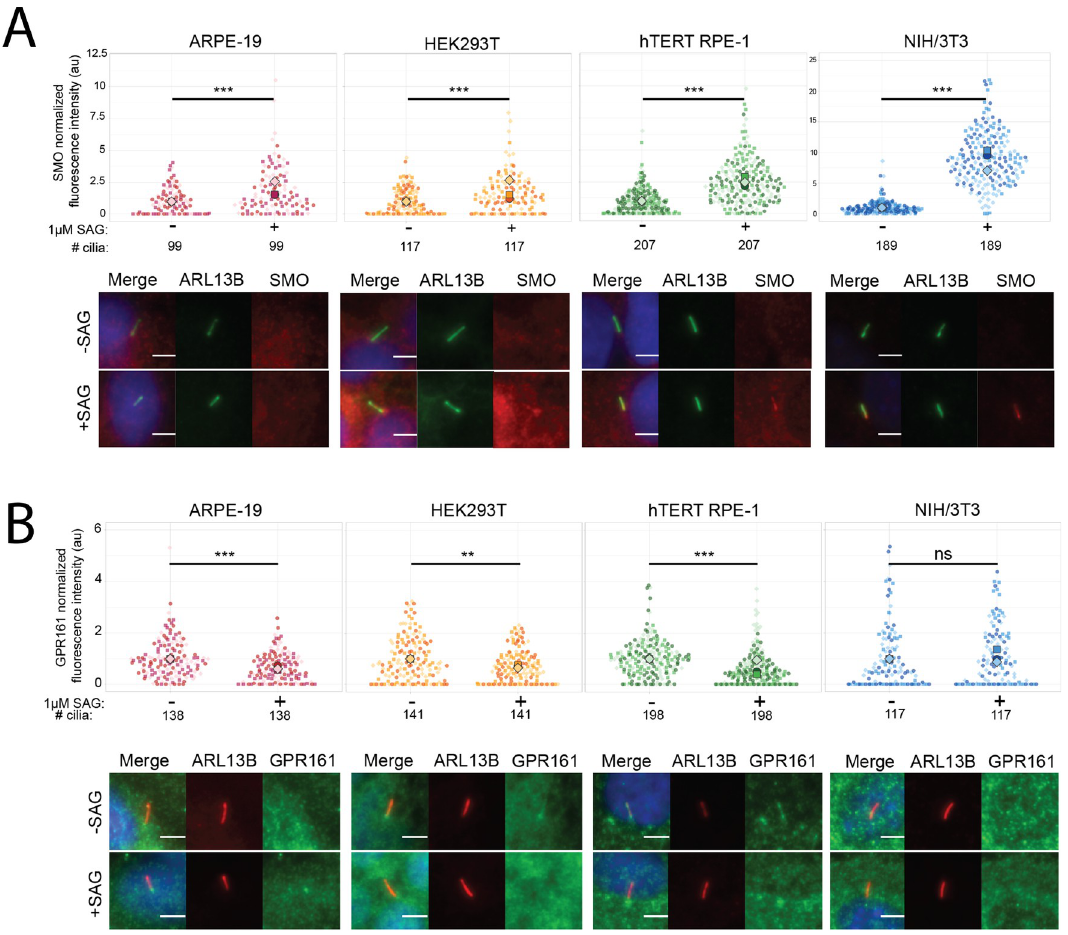
Fig 2. SMO and GPR161 localization in response to Hh pathway stimulation. Normalized fluorescence intensity (au) of A) SMO and B) GPR161 with and without pathway stimulation. Large symbol = median normalized fluorescence intensity for individual coverslip data. Small symbol = normalized fluorescence intensity of one cilium. Measurement from three separate batches are indicated by a unique symbol shape and color. Total number of cilia measured listed in the second row below the graph. Representative images are shown below graphs for unstimulated (-SAG) and stimulated (+SAG) cells. Two-tailed Student’s t- test was performed. P -values represented significant differences if they ranged from 0.01 to 0.05 ( � ), 0.001 to 0.01 ( �� ), and < 0.001 ( ��� ).